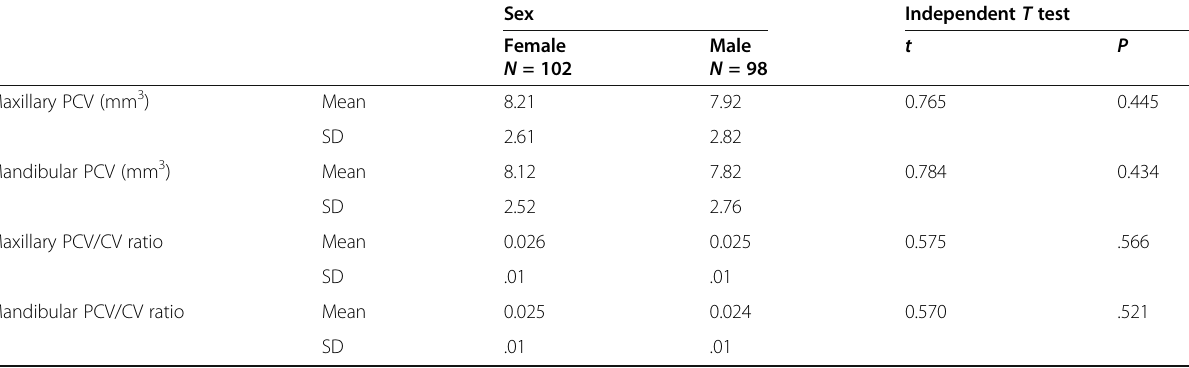
Table 2 Comparison of maxillary and mandibular pulp chamber volumes and pulp chamber/crown volume ratios between both sexes